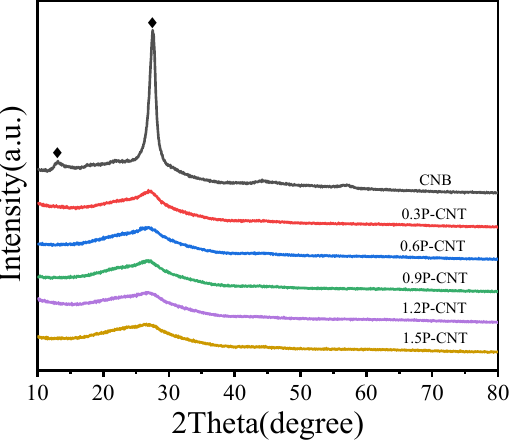
Figure 1. The XRD patterns of the CNB, 0.3P-CNT, 0.6P-CNT, 0.9P-CNT, 1.2P-CNT, and 1.5P-CNT samples.